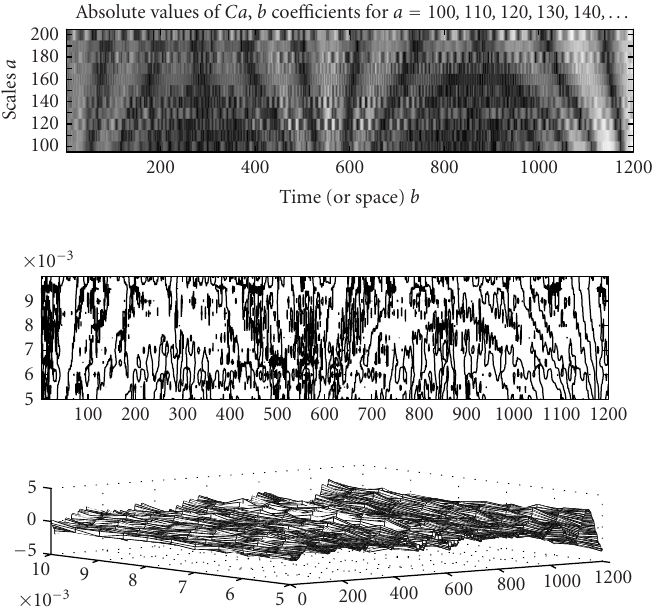
Figure 3.6. Continuous wavelet transform with morlet wavelet.